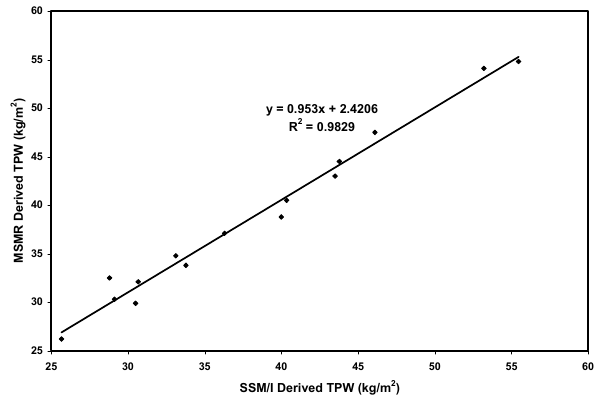
Fig. 2. Scatter Plot between SSMI derived TPW and MSMR derived TPW for June 2000. Fig. 3a. Monthly Variations of TPW with Indian Ocean SST (IO SST) during 1994